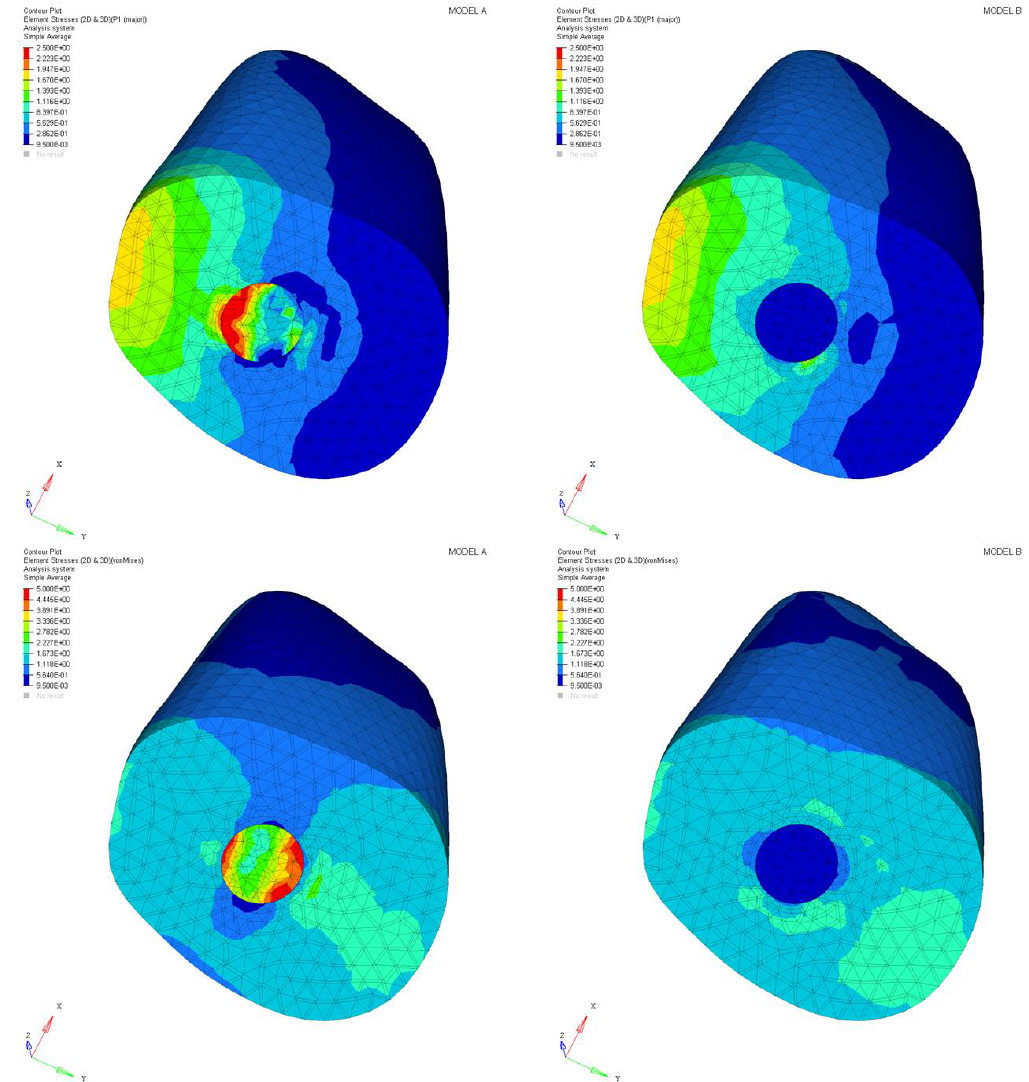
Figure 13. Maximum principal stress and von Mises stress distributions (MPa) in the cross-section at the cervical margin—scheme of Figure 12.